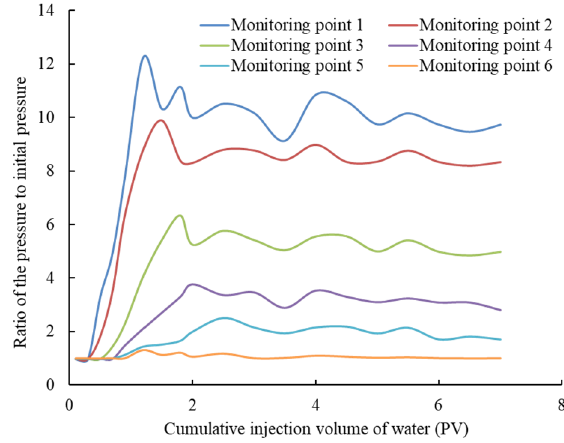
Figure 7. Pressure changes at each monitoring point for model No. 1 after plugging.